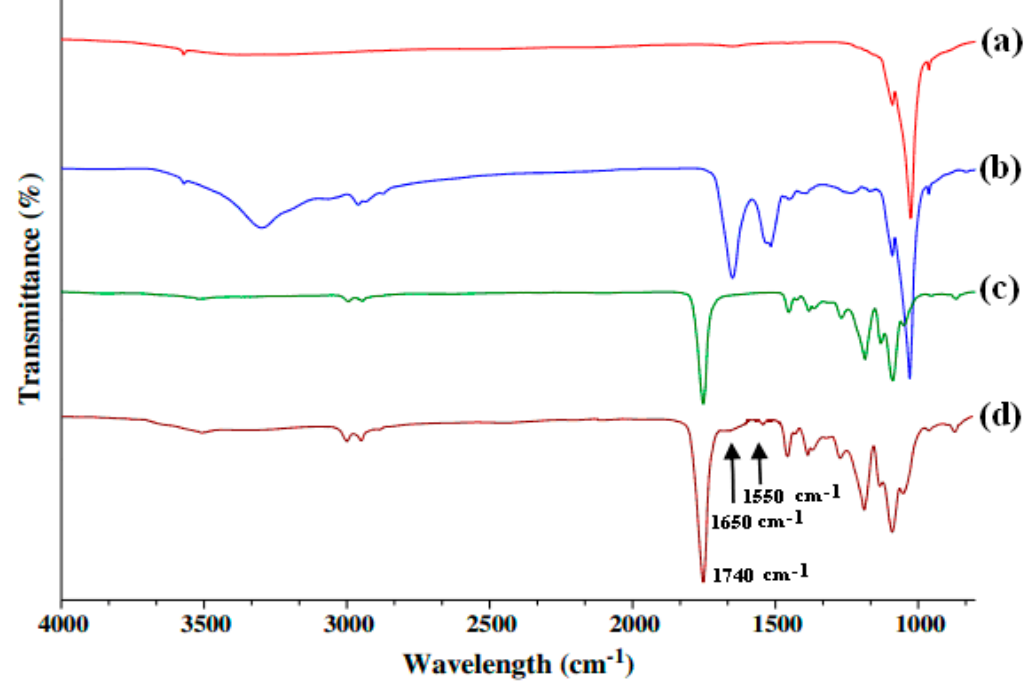
Figure 18. FT − IR spectra of ( a ) pristine nHA, ( b ) nHA-I, ( c ) pristine PLGA, and ( d ) PLGA/nHA-I [70].